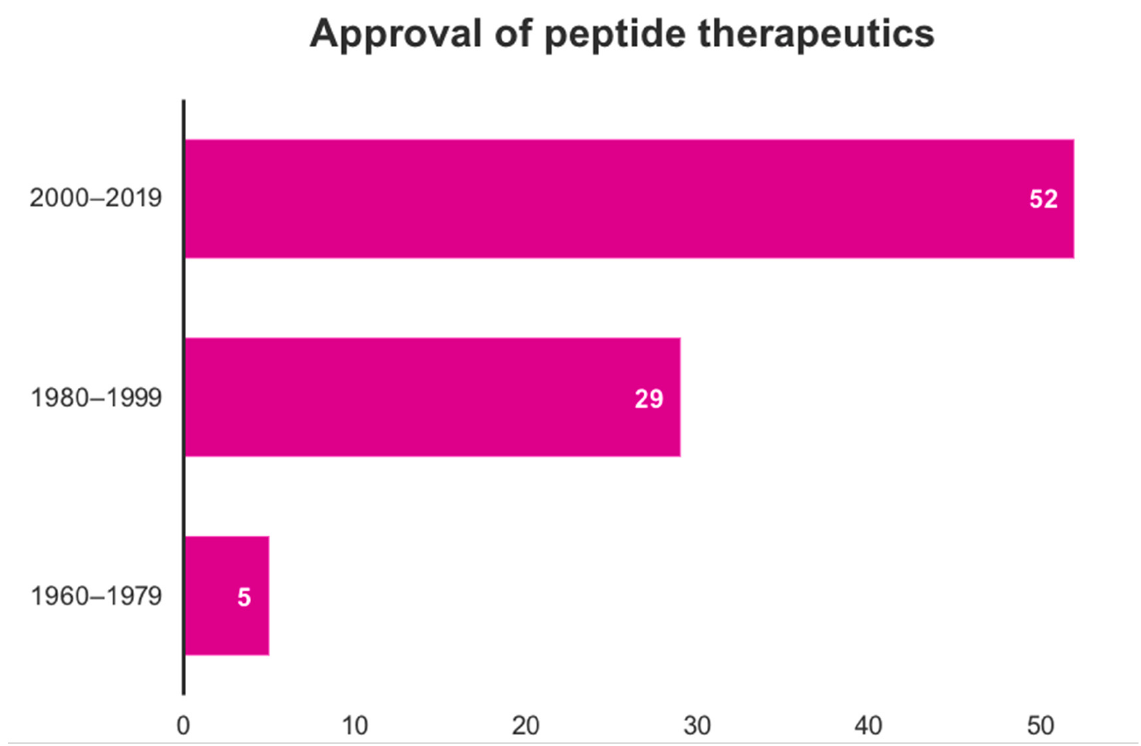
Figure 2. Increasing trend in peptide-based drugs.